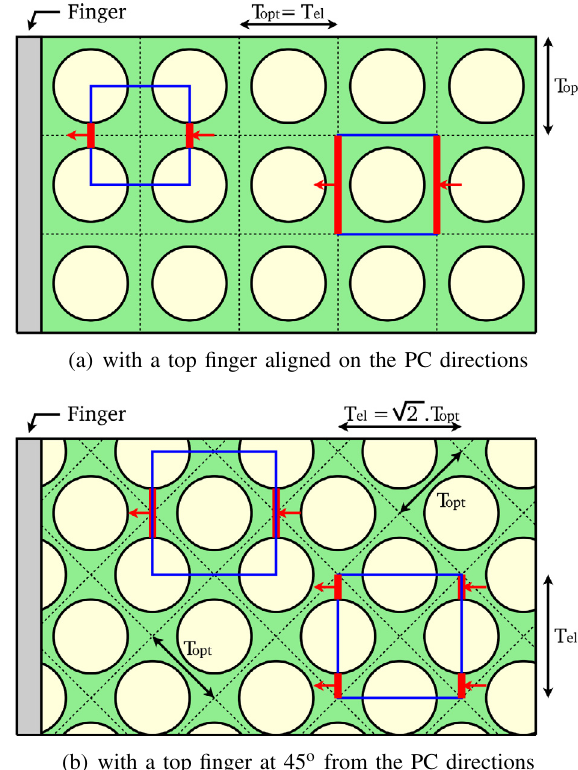
Fig. 2. Top view of a square lattice of round holes in the TCO. Blue squares represent the electric periodic pattern and red arrows represent the current flows in direction to the metallic finger.